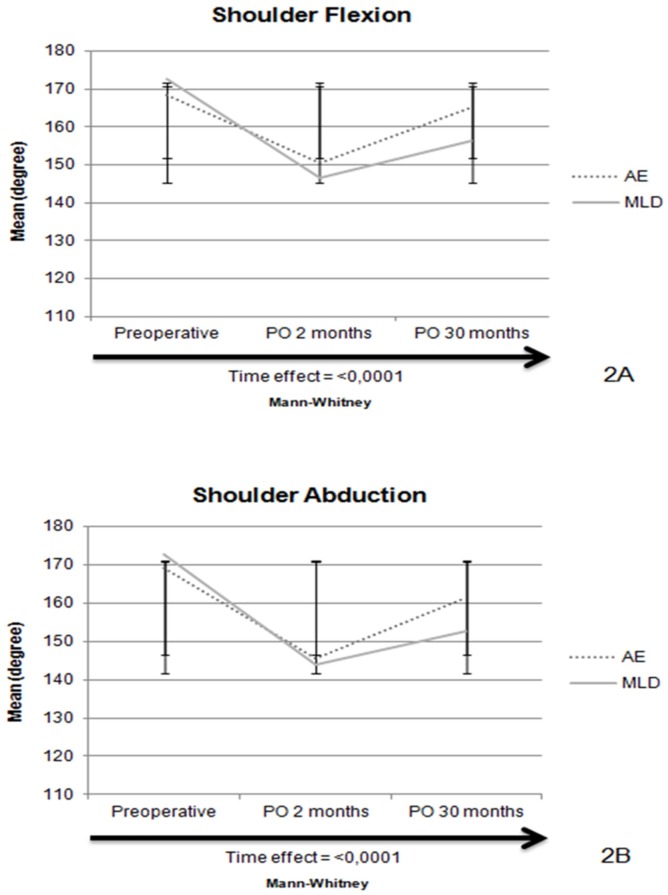
Mean shoulder flexion (2A) and abduction (2B) at the preoperative of surgery, two and thirty months later, according to group.